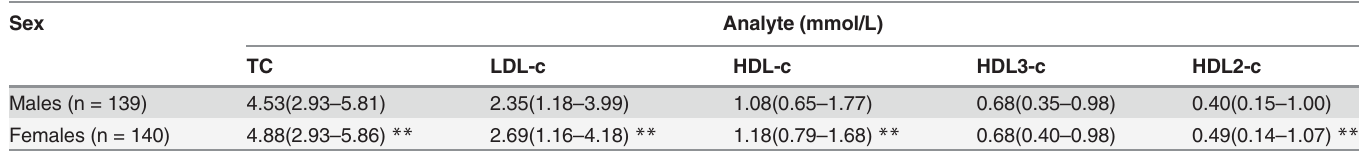
Table 4. Reference Ranges of cholesterol fractions according to sex [median (percentiles 2.5 et 97.5)].